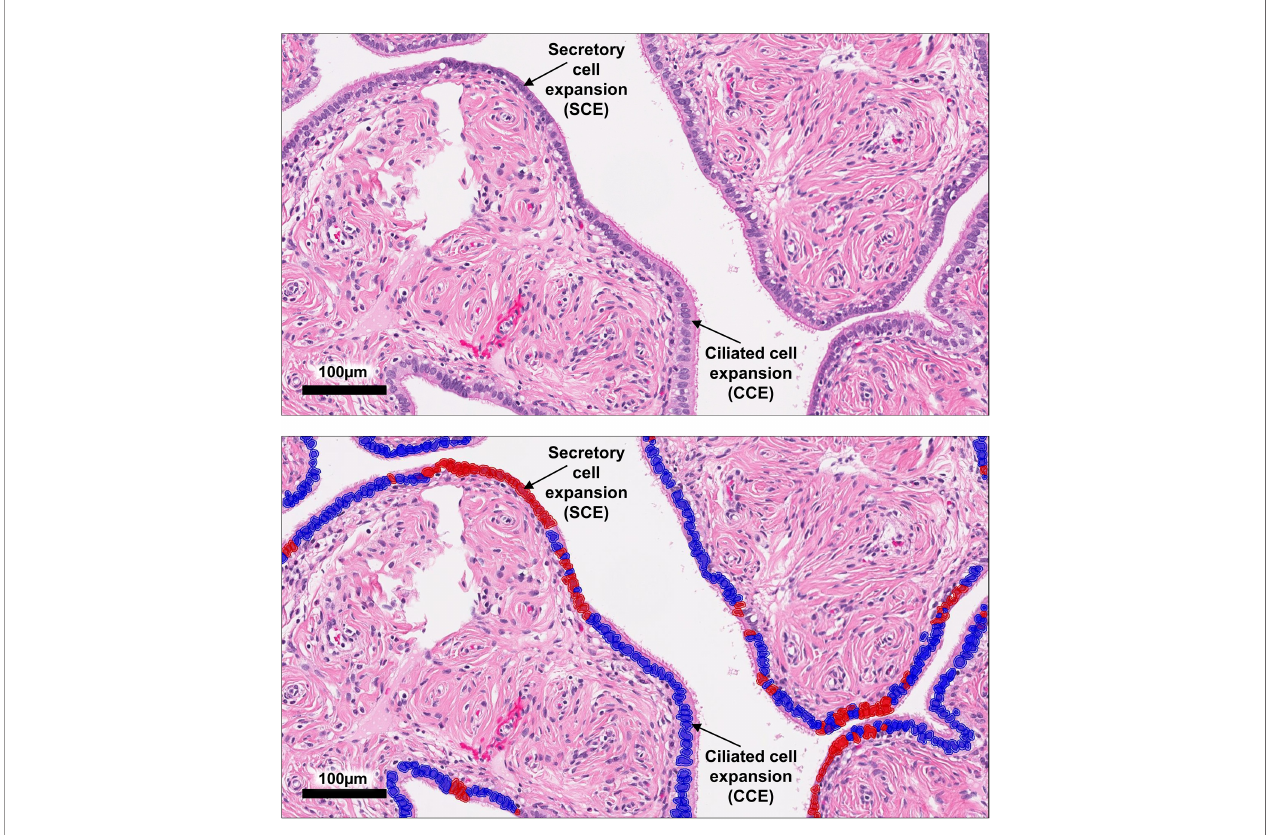
FIGURE 2 | QuPath analysis of epithelial cells in the fallopian tube. A representative image of an ampulla region with SCE and CCE, which are de fi ned as a monolayer of >10 contiguous secretory or ciliated cells uninterrupted by the other cell type. The top panel shows the original H&E image while the bottom panel shows epithelial cell classi fi cation after ROI selection, cell segmentation, and classi fi er